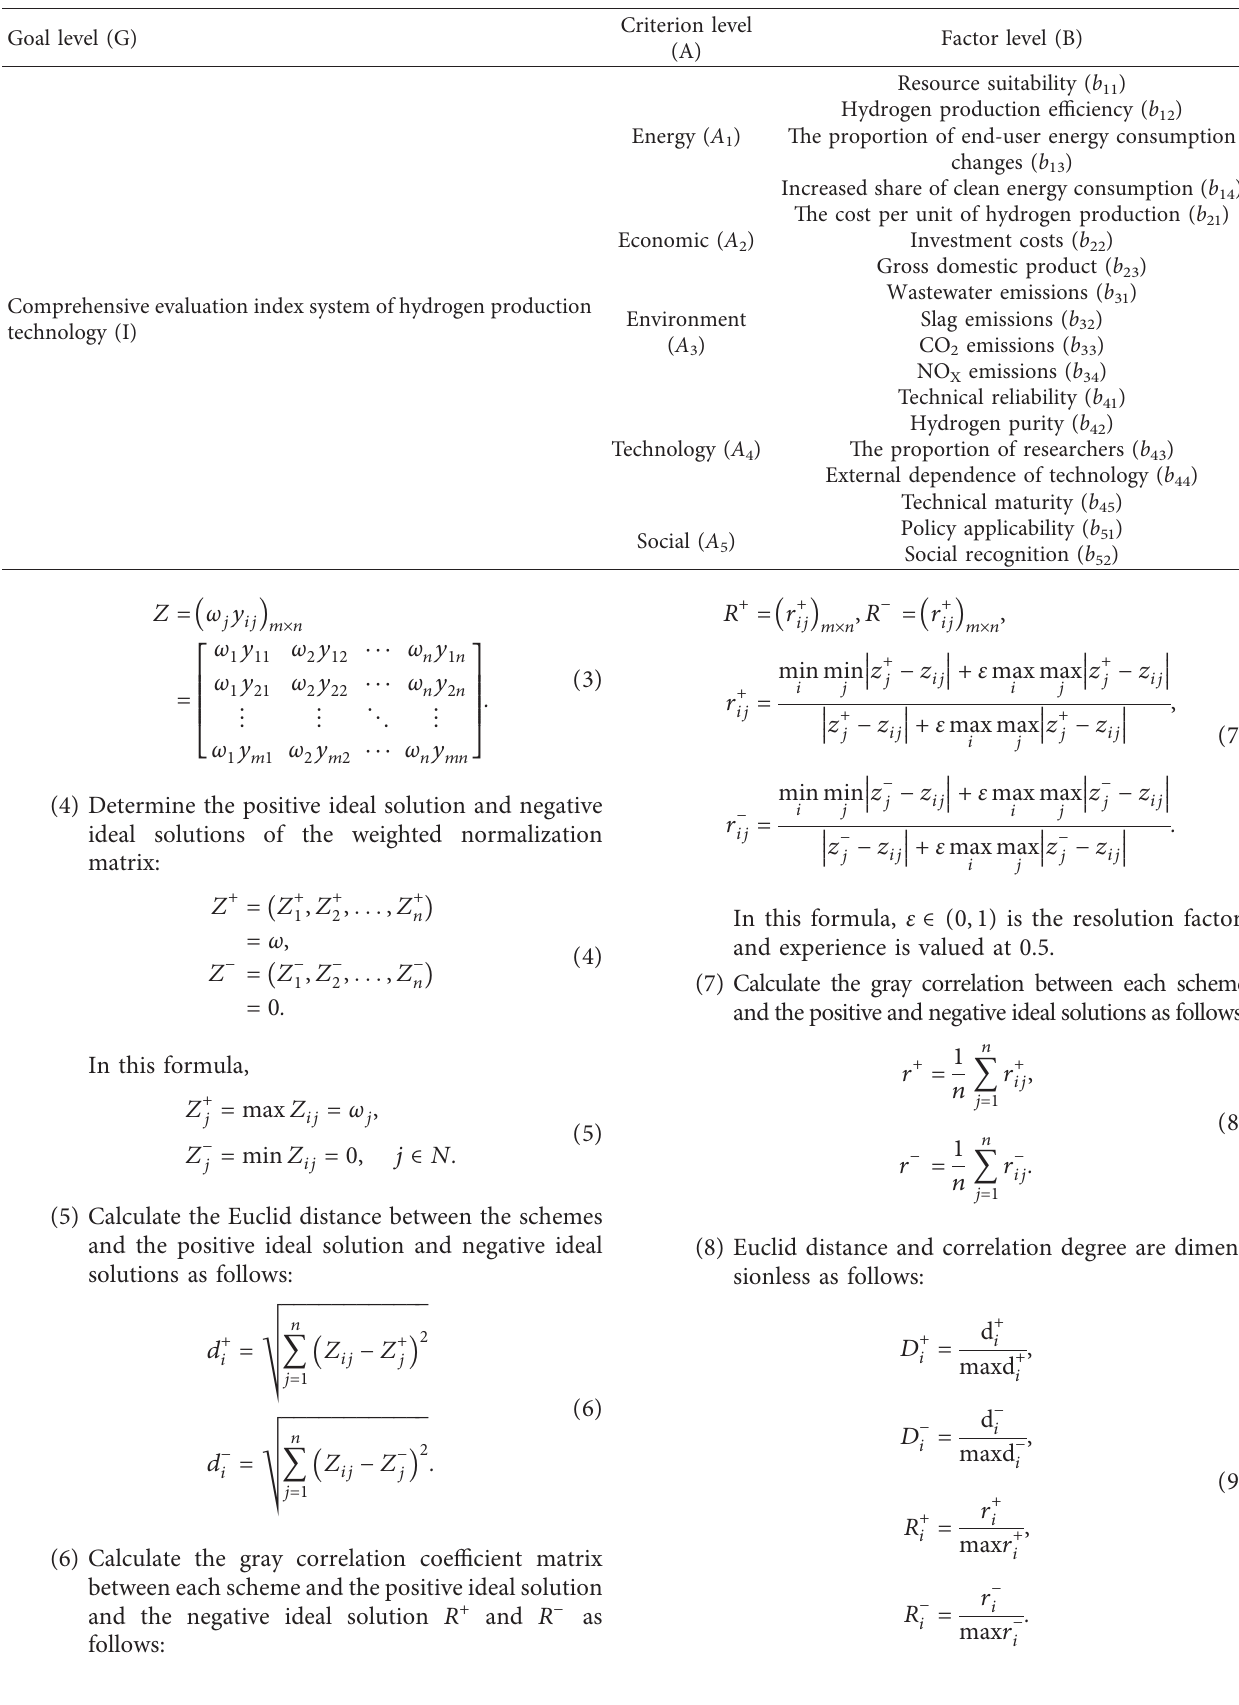
Table 1: Comprehensive evaluation index system of hydrogen production